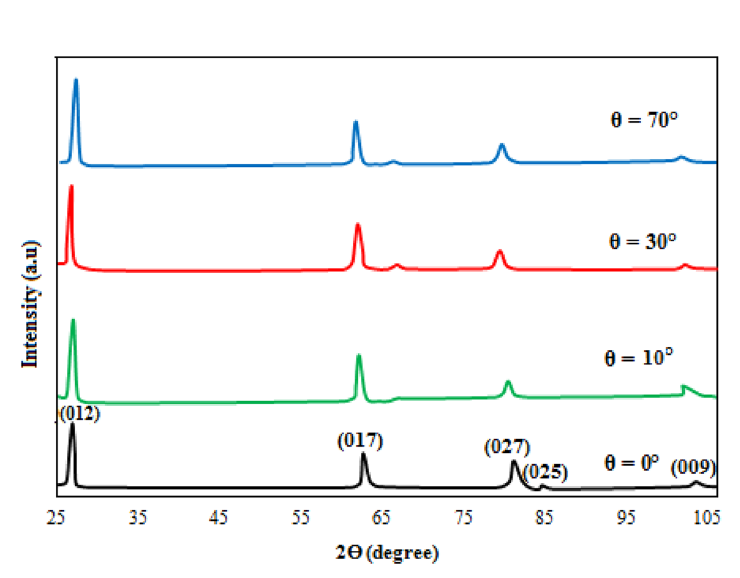
Figure 2. XRD patterns of antimony films deposited at θ = 0, 10, 30, and 70°.